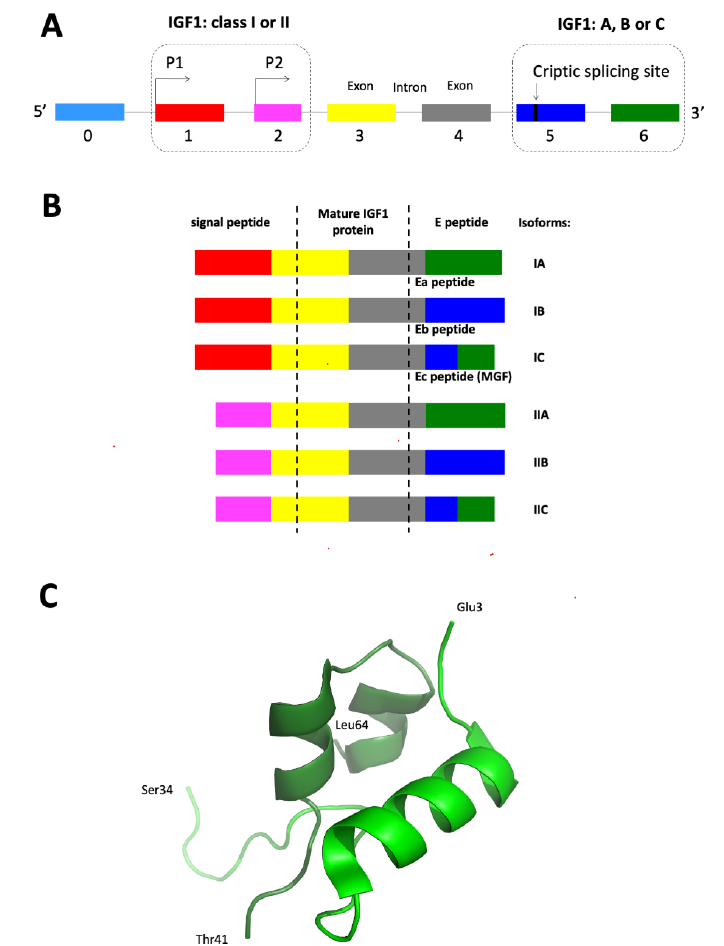
Figure 1. Simplified model of the human IGF1 gene structure ( A ), featuring main mRNA isoforms (variants) generated by alternative splicing and encoded precursor peptides ( B ), with the three-dimensional structure of IGF1 protein determined by X-ray crystallography, based on PDB no. 1IMX [79] ( C ). The human IGF1 gene is composed of 6 major exons and a newly discovered exon 0, upstream of exon 1 [54]. Splicing and exons in the human IGF1 gene generate distinct transcripts that vary in the 5′ and 3′ ends though the mature IGF1 protein is invariant. Transcription starts from one of the two promoters (P1 and P2) located in exon 1 and 2, respectively. Exons 1 and 2 are alternatively utilized and comprise IGF1 class I and II, respectively. Exons 3 and 4 are expressed in all known isoforms. Exon 5 is absent in isoform A (class I / II), but it forms isoforms B and C (class I / II). Transcripts containing exon 4 spliced directly to exon 6 are also referred to as IGF1Ea, those containing exon 5 spliced to exon 4 (and lacking exon 6) are referred to as IGF1Eb (unique to humans). The IGF1Ec splice variant in humans is an exon 4–5–6 variant. All peptide products derived from pro-IGF1 are shown. For details see